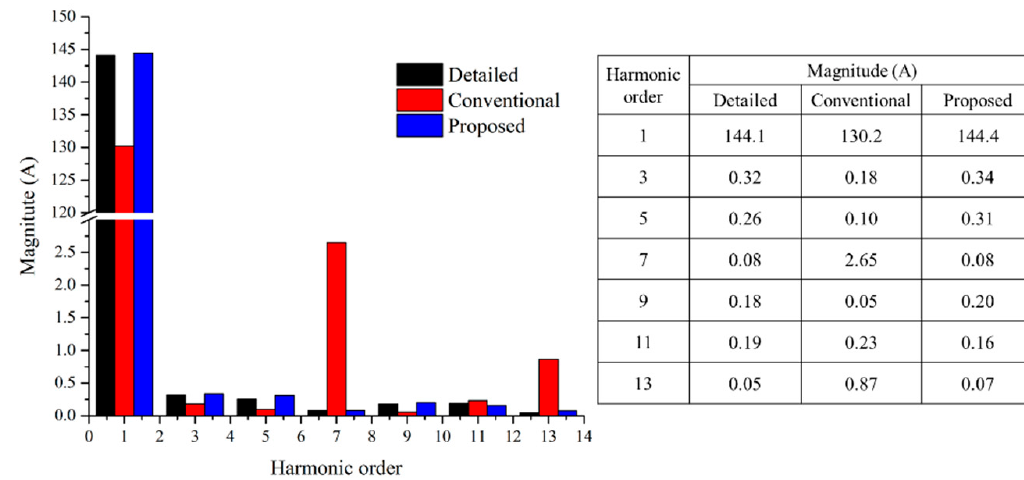
Figure 4. Comparison of dynamic characteristics at rated speed and rated load torque. ( a ) Phase u voltage; ( b ) Motor Speed; ( c ) Phase u currents; ( d ) Output Torque.